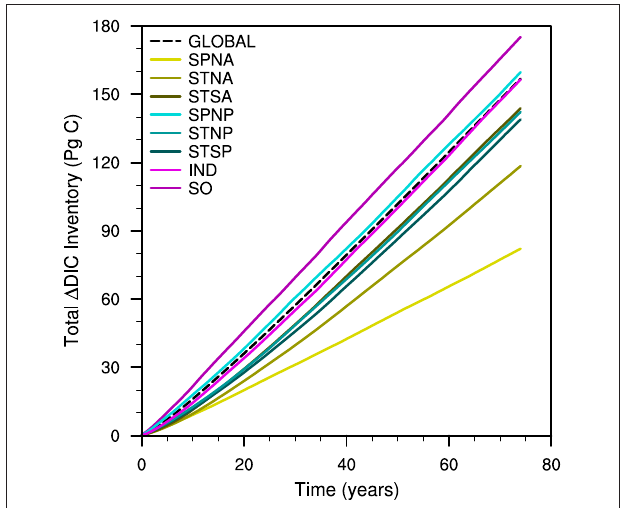
FIGURE 6 | Time series of the percentage of total surface total alkalinity anomalies within the defined region over time for the global and different regional ocean alkalinity enhancement experiments.